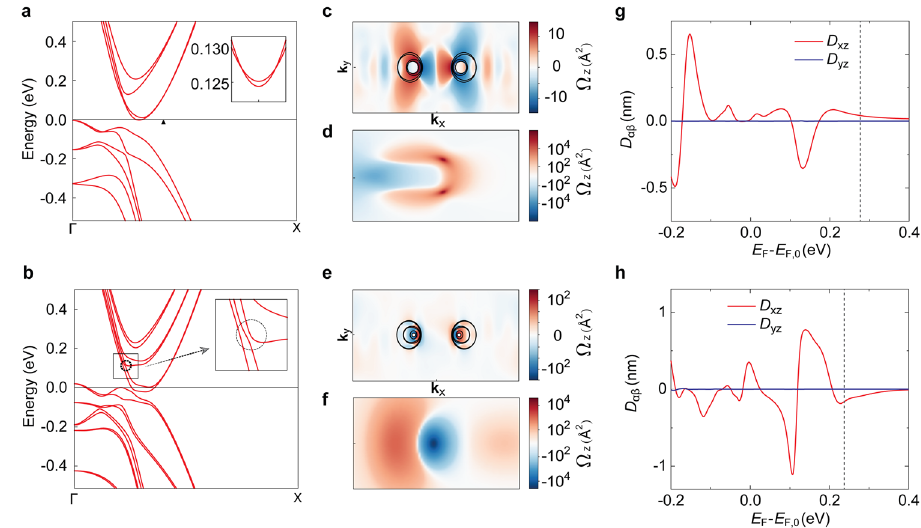
respectively. The black solid lines are Fermi lines. d and f are the zoom-in of Berry curvaturenearcorrespondingcrossing/anti-crossingpointsintheareasde fi nedby (cid:1) (cid:3) (cid:1) (cid:3) and k y 2 (cid:1) 0 : 04 2 π b ,0 : 04 2 π b for d and k x 2 intervals k x 2 0 : 16 2 π a ,0 : 24 2 π a (cid:1) (cid:3) (cid:1) (cid:3) and k y 2 (cid:1) 0 : 04 2 π b ,0 : 04 2 π b for f . g , h Berrycurvaturedipoleas 0 : 075 2 π a ,0 : 155 2 π a function of chemical potential for bilayer ( g ) and trilayer ( h ), respectively. Dotted linesin g and h denotesFermienergyof0.28eVand0.24eVforbilayerandtrilayer samples, respectively.